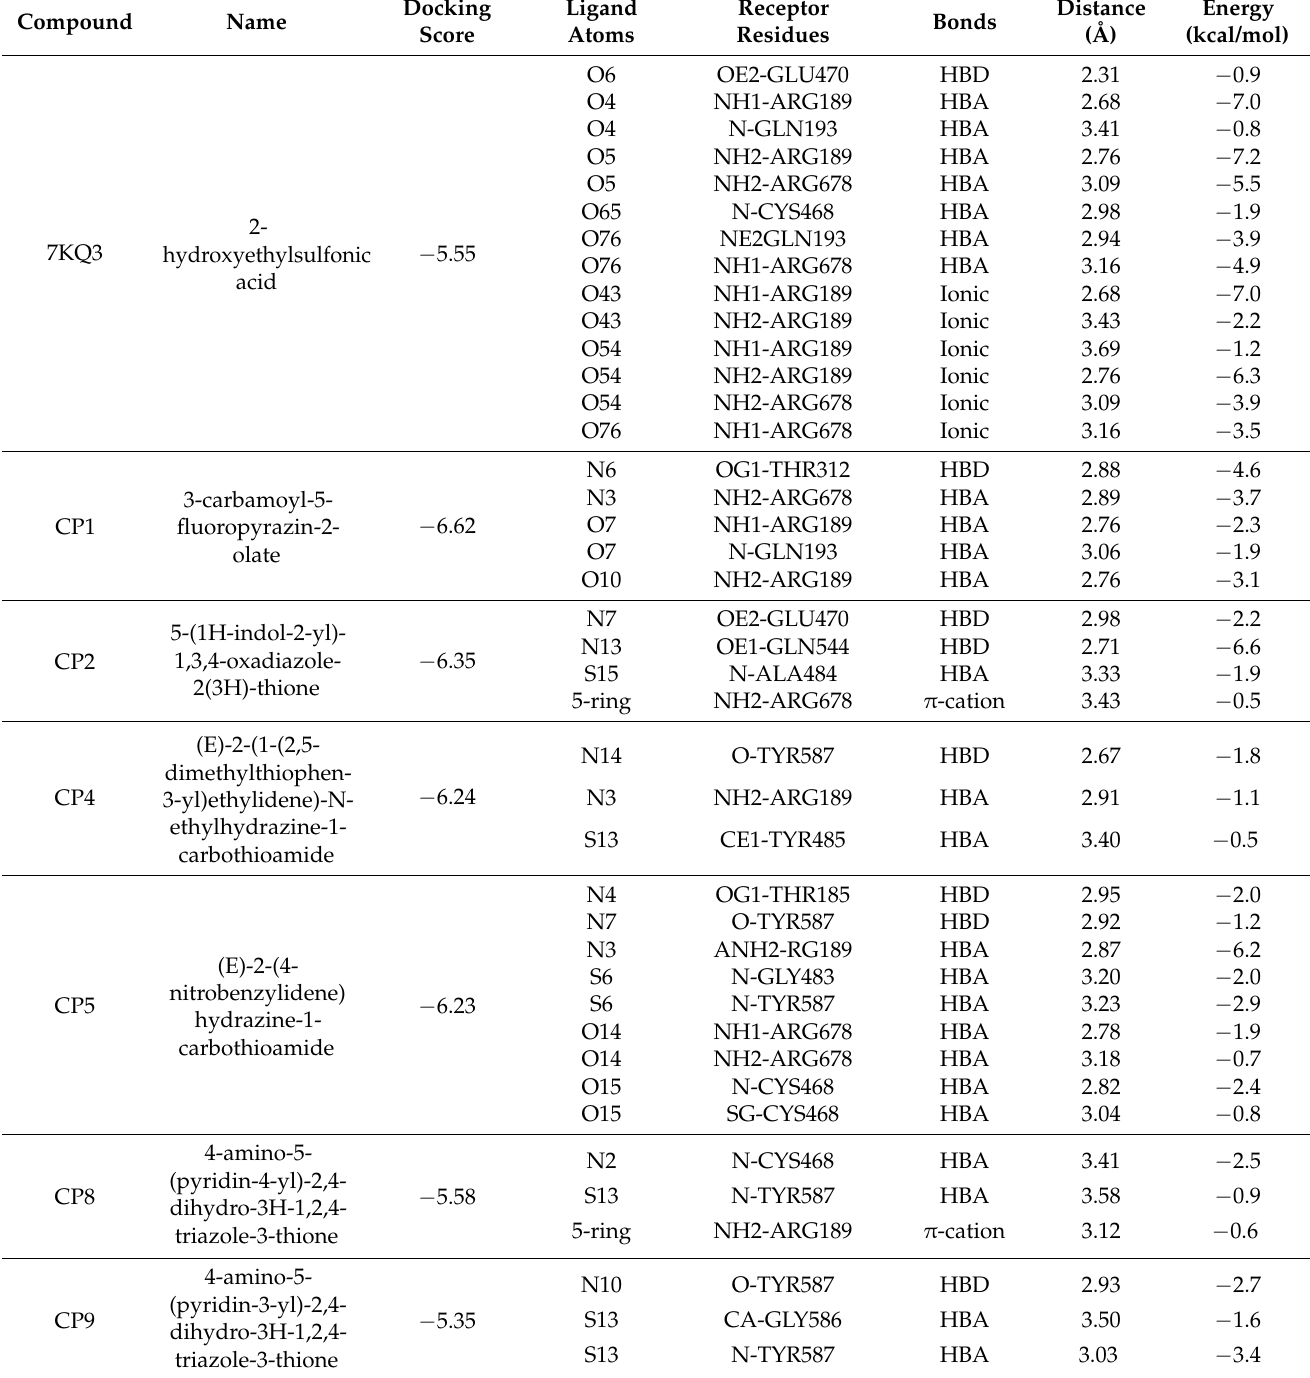
Table 1. The molecular interactions between compounds and the active site residues of isethionate